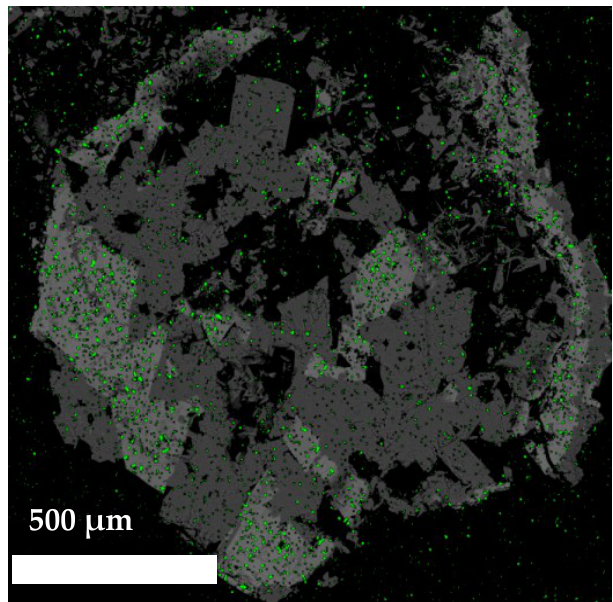
Figure 3. Fluorine distribution within the oxalate-bearing stone, Sample 10. BSE image. Crystals 2020 , 10 , 486